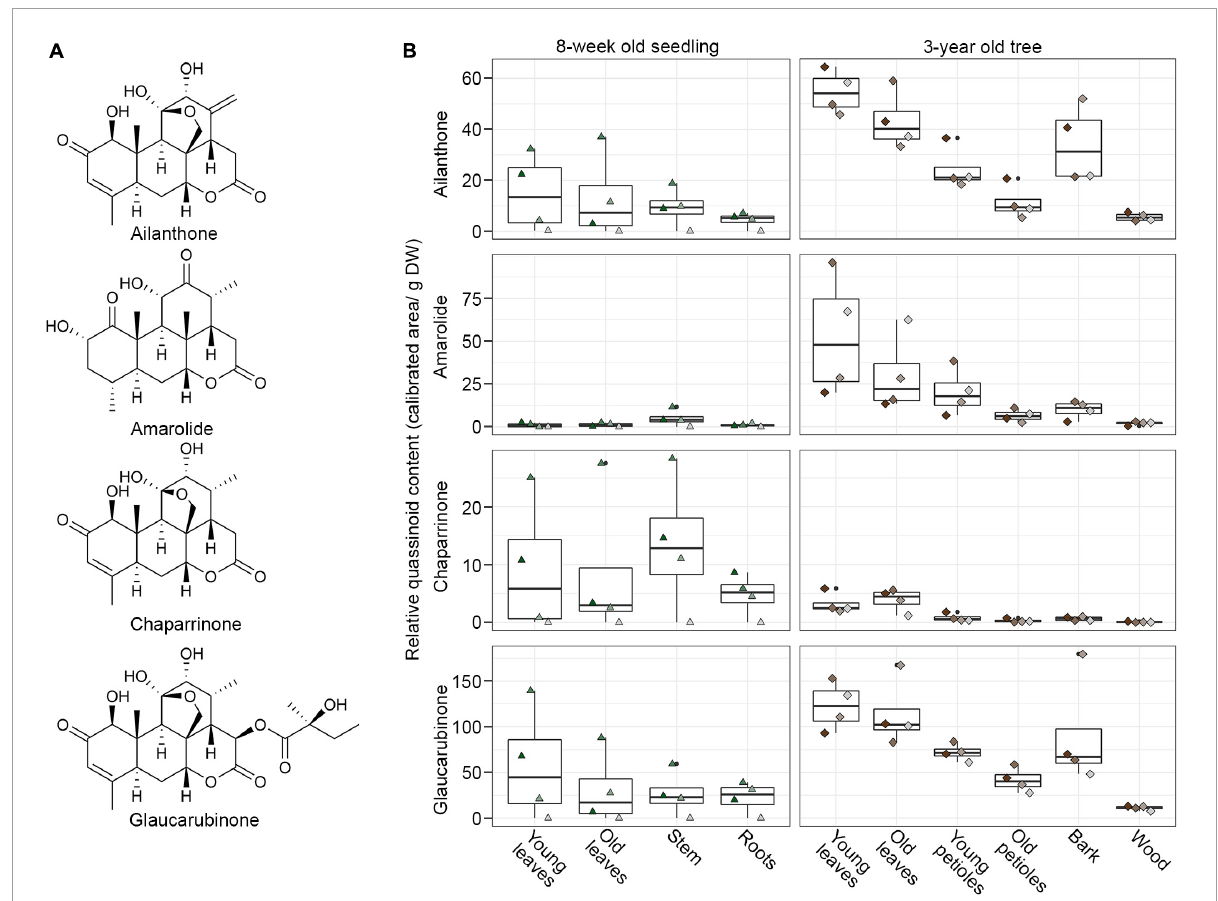
FIGURE2 Distribution of four main quassinoids in different tissues of Ailanthus altissima seedlings and trees. (A) Structures of main quassinoids. (B) Levels of the four main quassinoids as determined by LCMS. The data is represented samples were normalised by dry weight to account for differences in tissue water content. The data distribution is represented as a boxplot; the centre line of the box indicates the median value, whereas the lower and upper borders of the box correspond to the first and third quartile, respectively; the whiskers indicate the lowest and highest data points, excluding